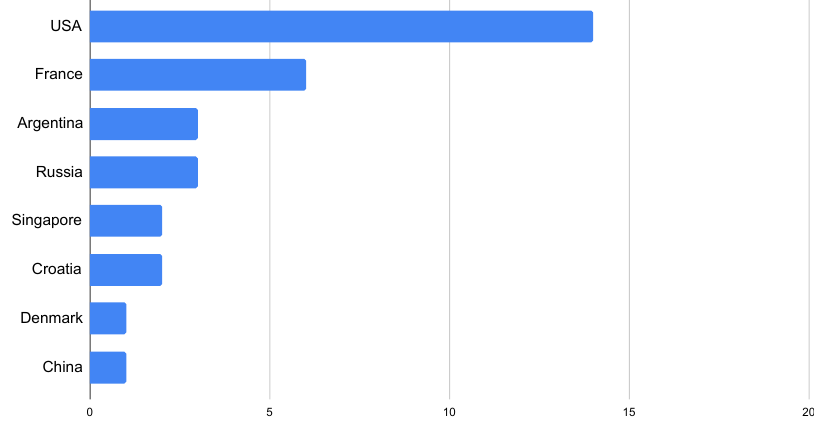
Figure 3. Number of authors by country.